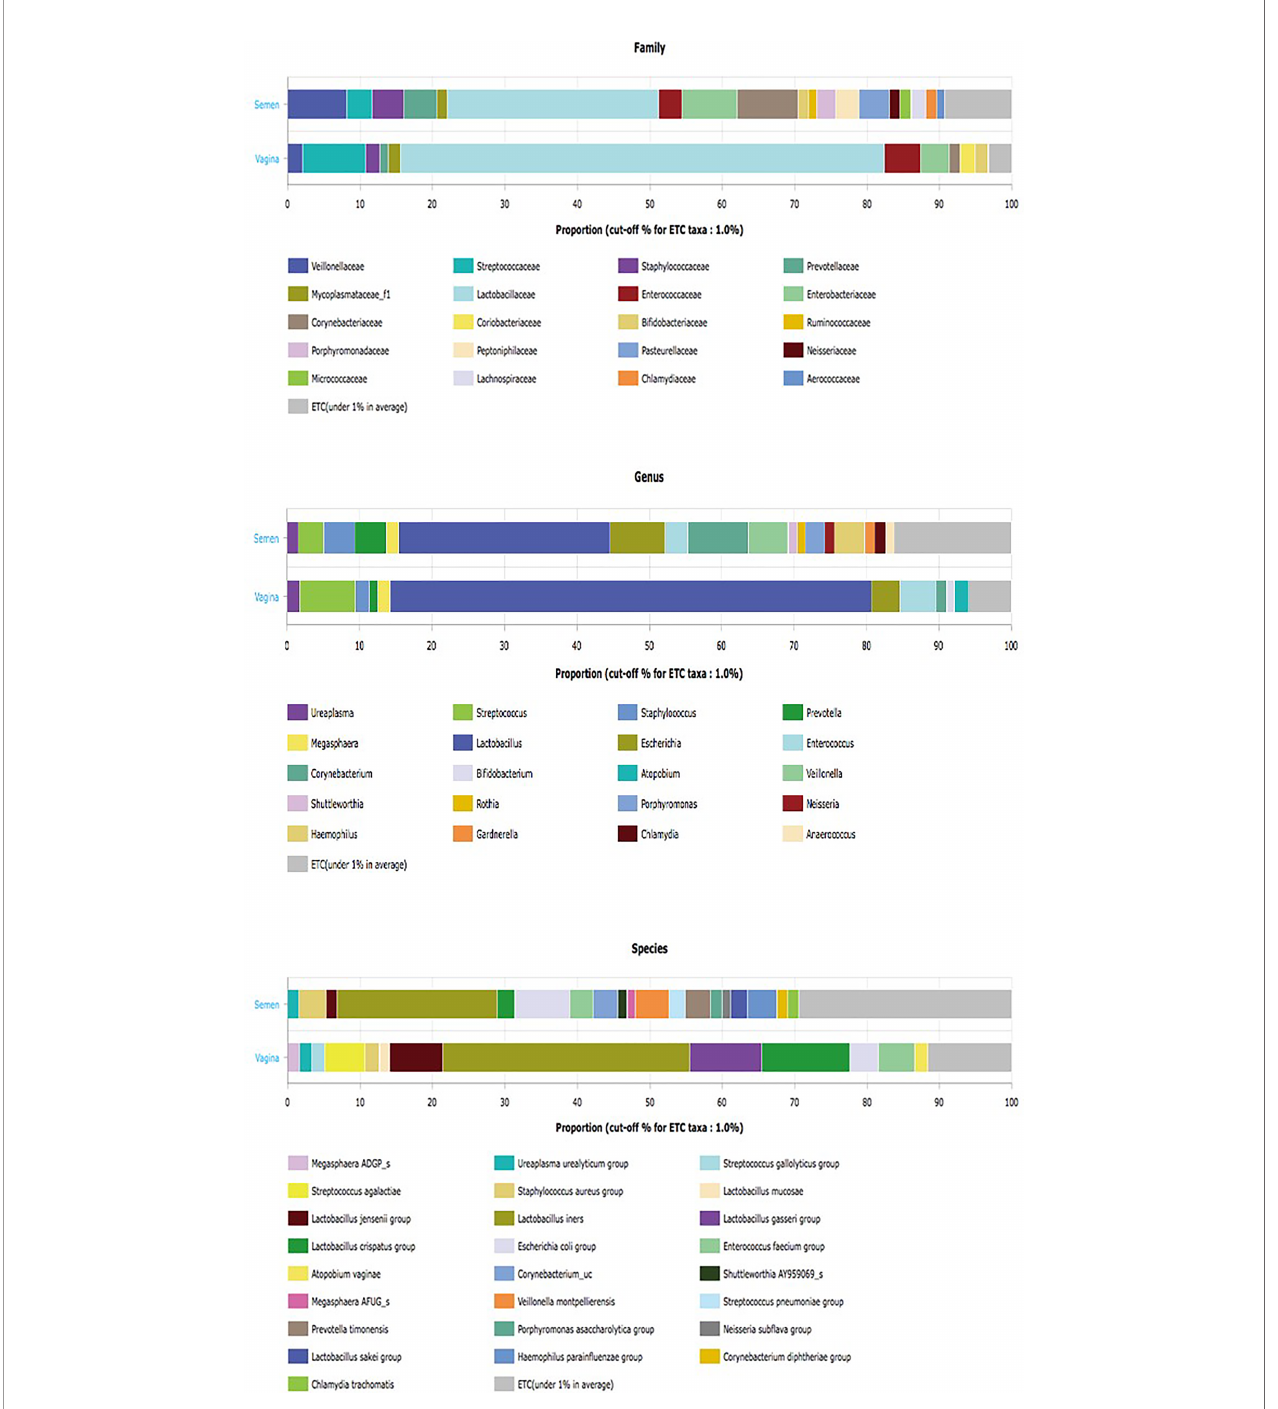
iron/zinc/manganese/copper transport system permease protein (P=0.0326) and diphosphoinositol-polyphosphate diphosphatase (P=0.0369) had a twofold increase with positive IVF clinical outcome when compared with negative IVF clinical outcome ( Table 4